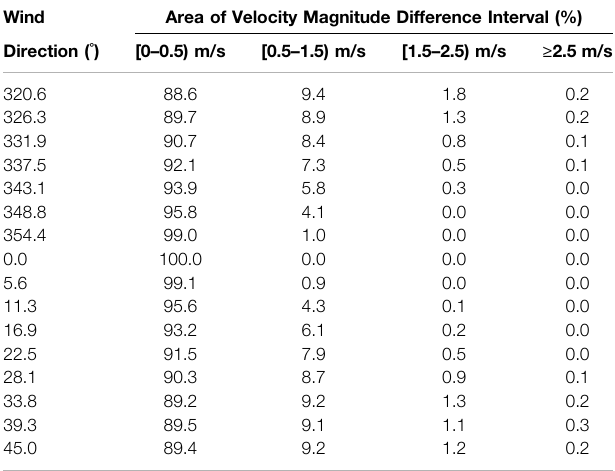
TABLE 6 | Area of intervals of wind speed difference to reference wind direction simulation at 2 m above ground. The 16 included simulations represent wind from a 90 ° wide sector around the reference wind direction N (0 ° ). The compared area is within 100 m in each horizontal direction of the high-rise building and does not include the buildingfootprint area. This table quanti fi es theobservations in Figure 6